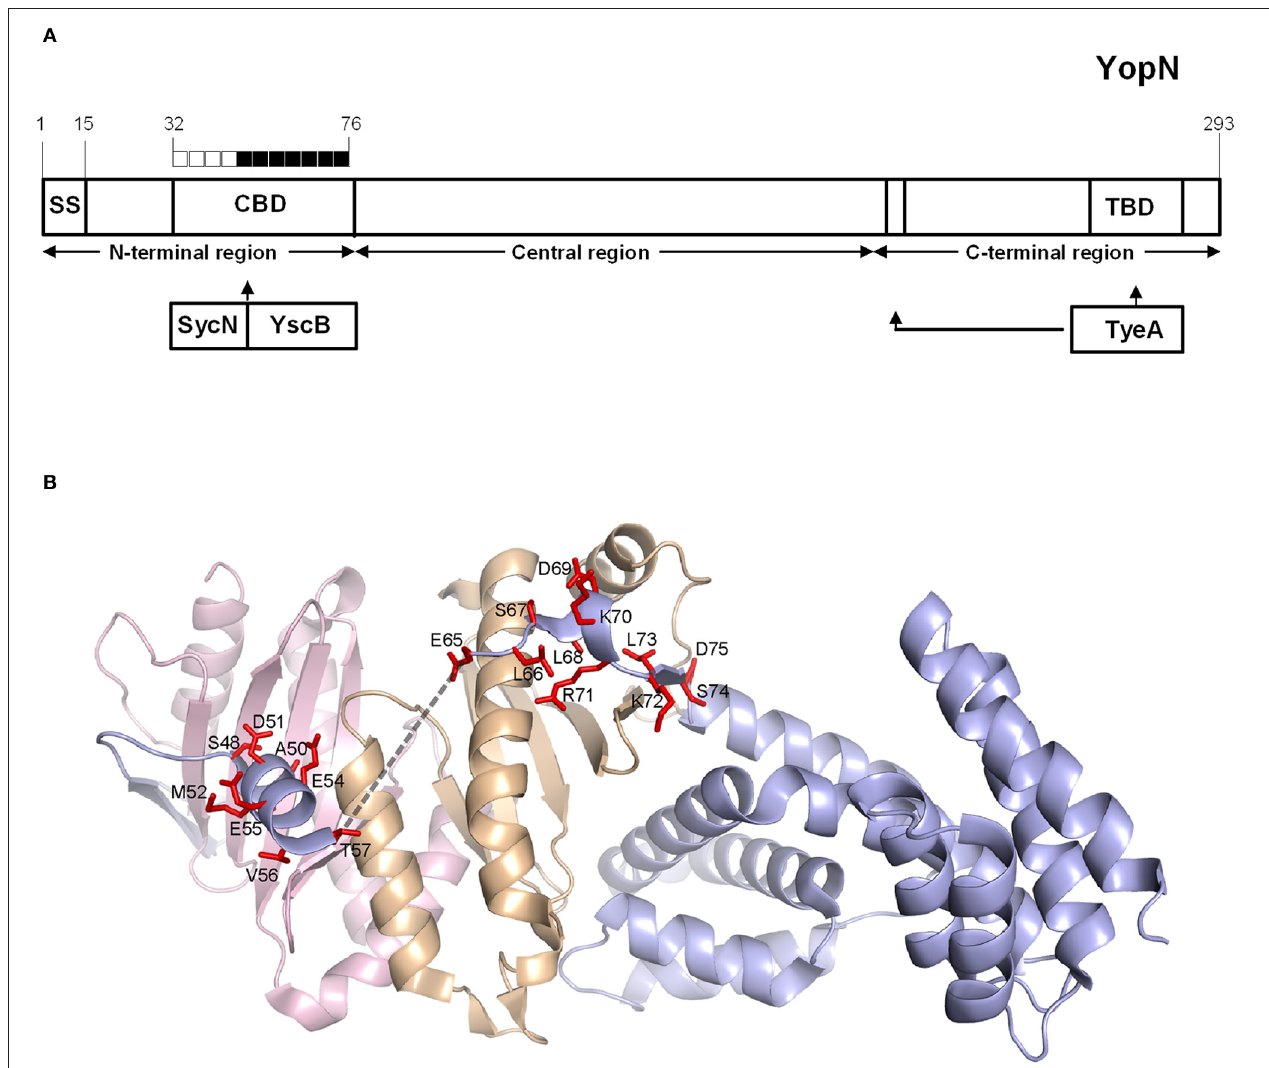
FIGURE 3 | Mapping of YopN CBD residues involved in the regulation of Yop secretion. (A) Diagram of YopN showing the location of the secretion signal (SS), chaperone-binding domain (CBD), and TyeA-binding domain (TBD). The extended arrow identifies additional residues contacted by TyeA. Boxes above YopN each represent four YopN residues substituted with four alanines in each YopN tetra-alanine mutant analyzed: open boxes = wild-type calcium-dependent Yop secretion; filled boxes =